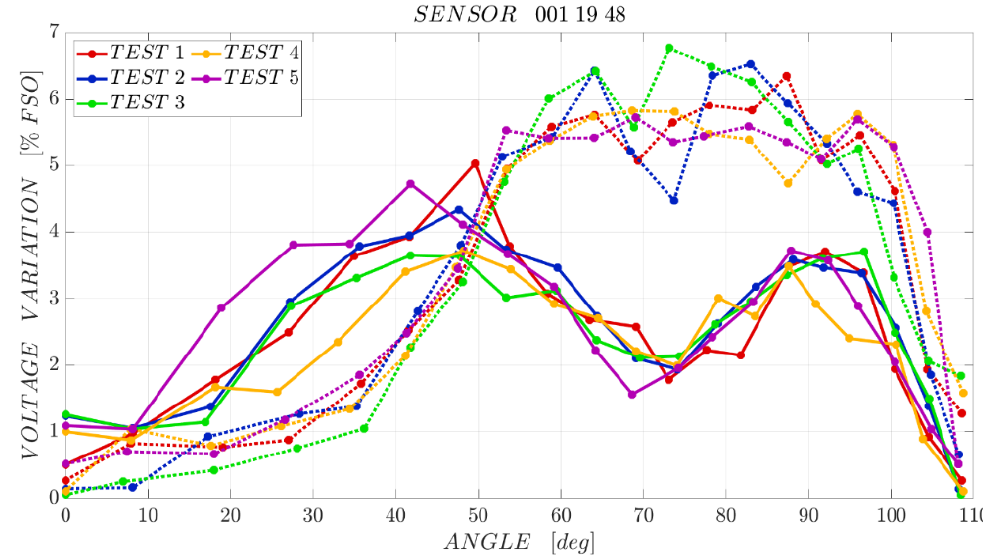
Figure 23. Linearity of the sensor 001 19 48.